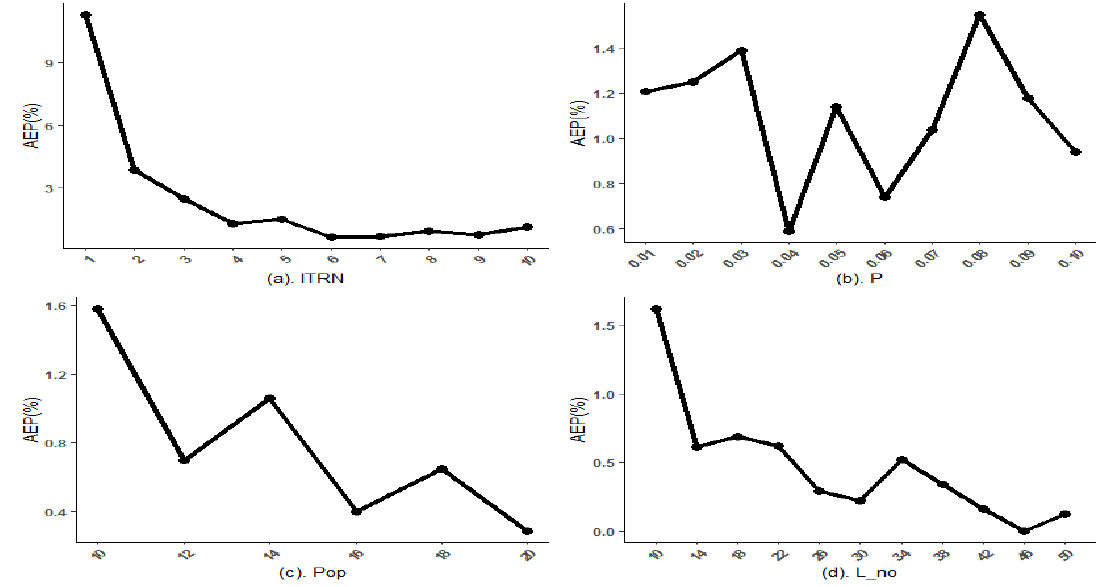
Figure 2. Tuning the GAHH parameters.